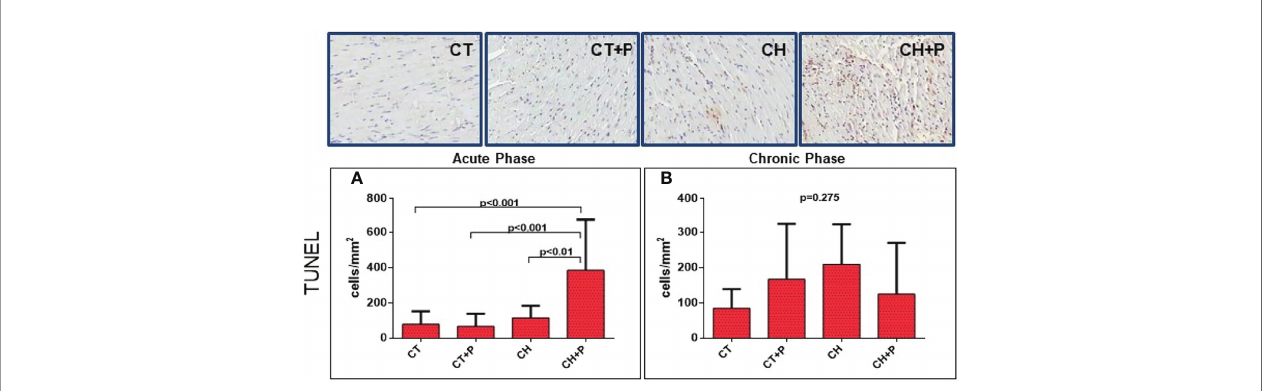
FIGURE 7 | Photomicrograph with apoptotic nuclear in brown color of the myocardium for detection of DNA fragmentation using the TUNEL technique, and graph of the quanti fi cation of apoptosis. (A) Apoptosis (TUNEL) in the acute phase (n=51); (B) Apoptosis (TUNEL) in the chronic phase (n=40). CT - control group, CT+P –